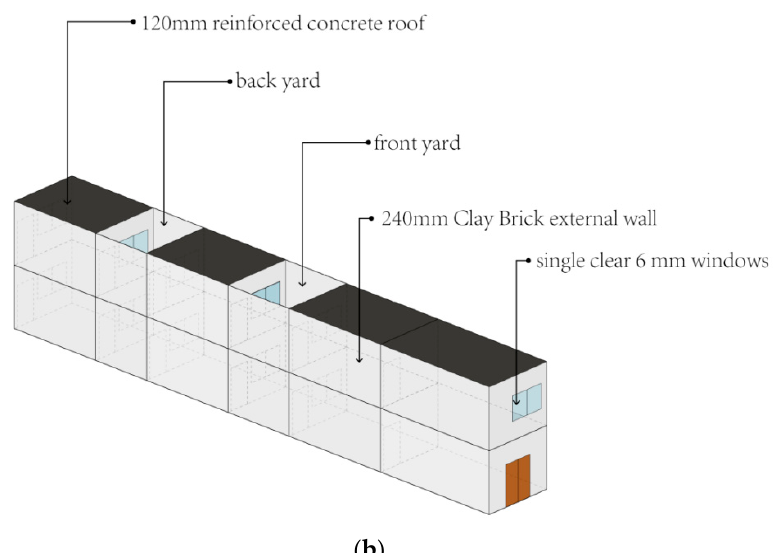
Figure 3. ( a ) Layout of a tubular house in CAD 2020, and ( b ) 3D model of a tubular house in Sketchup 2019.